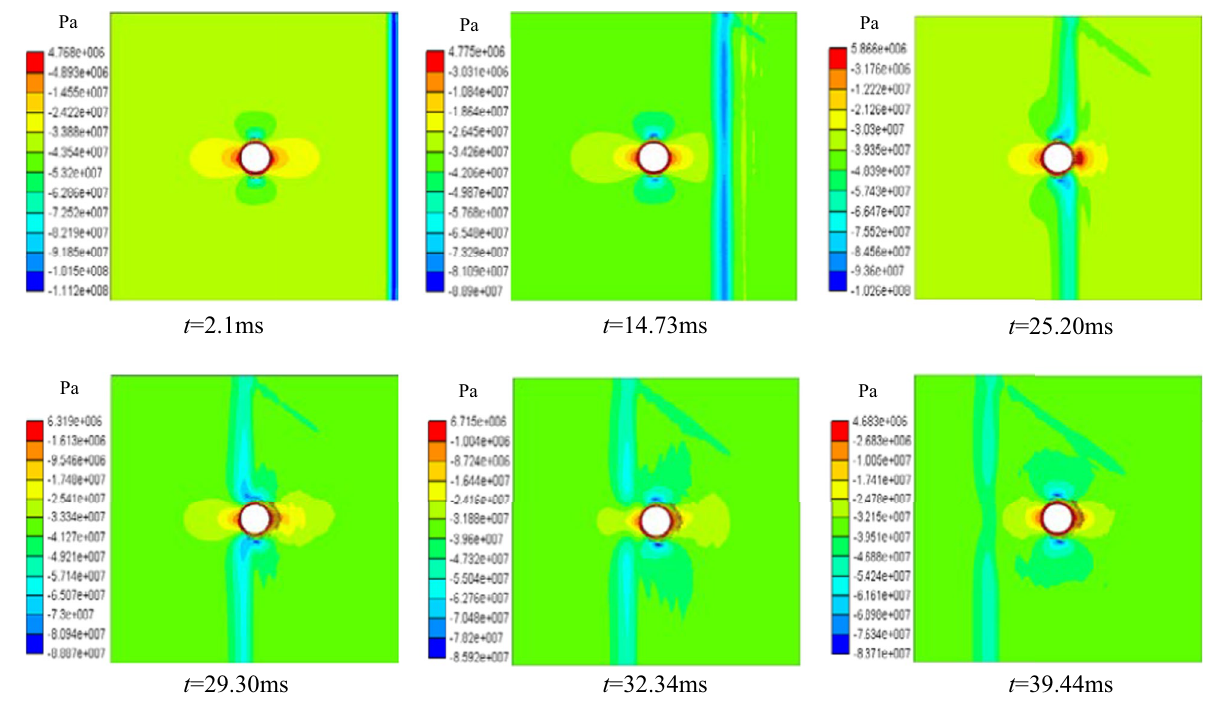
Fig. 11 Dynamic stress-wave propagation process in the model. Note: The dynamic stress-wave was imposed on right domain, and the amplitude is 80 MPa. The initial time starts from 2.5 s